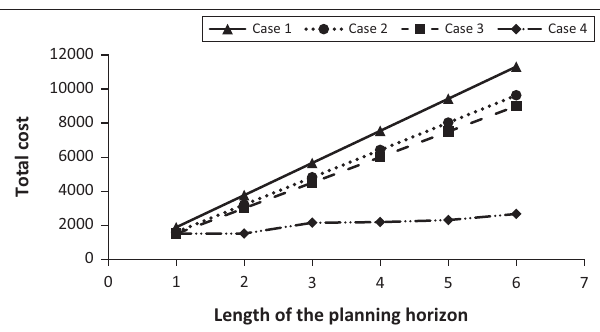
FIGURE 4: Total cost versus planning